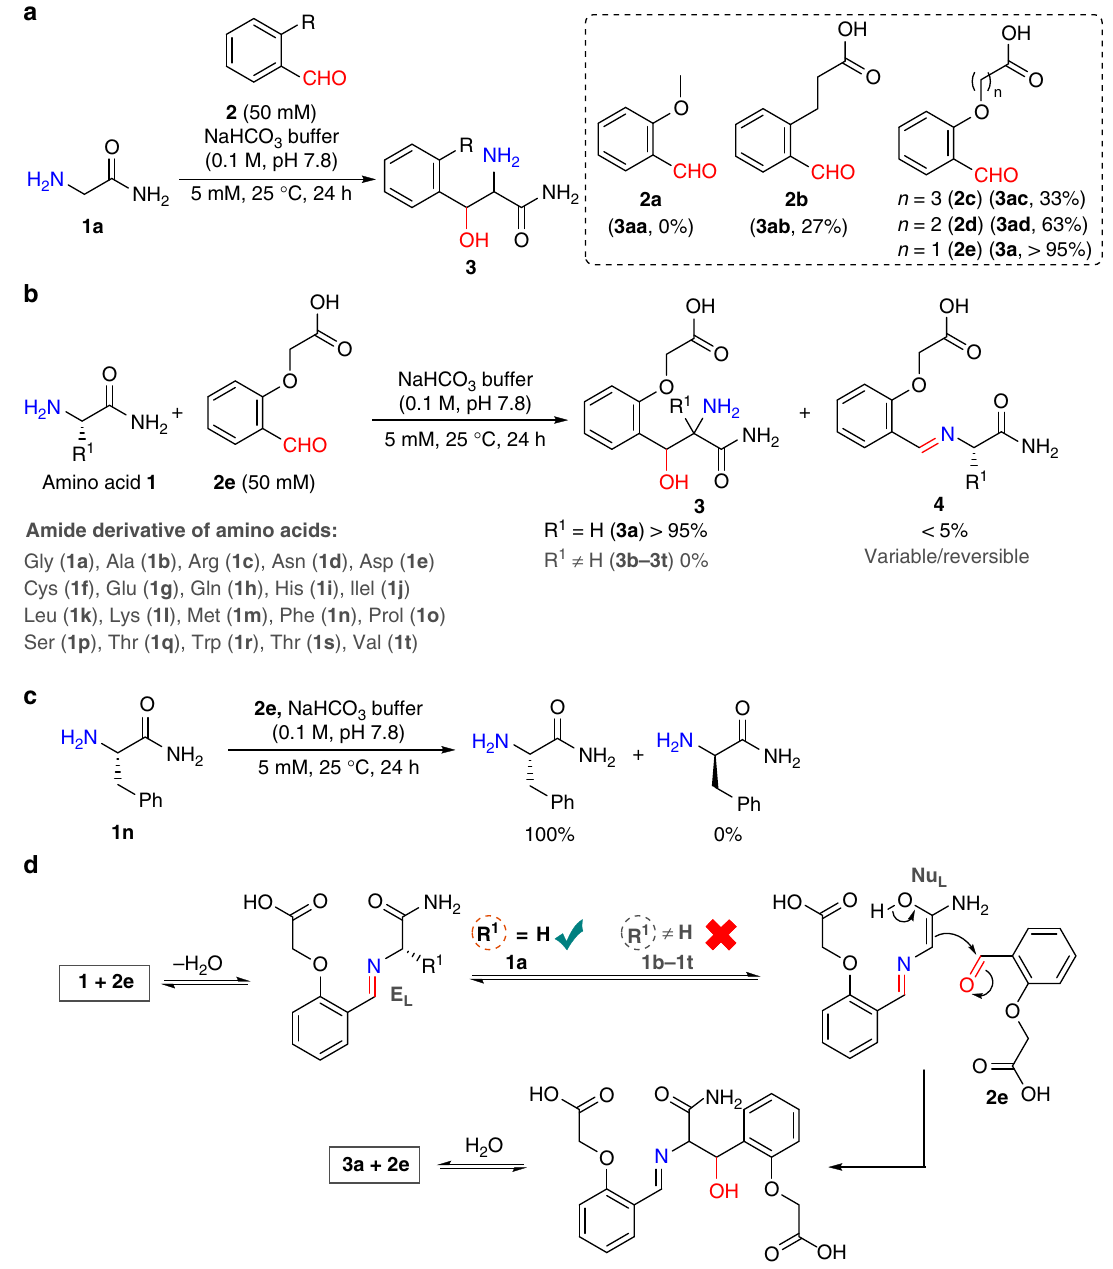
Fig. 2 Stable aminoalcohol formation with glycine. a Aldehyde with H-bond acceptors forms a stable aminoalcohol with 1a (also see Supplementary Fig. 72). b Selective formation of aminoalcohol with 1a . c Stereo-stability of substituted amino acid ( 1n ) under the reaction conditions. d Plausible mechanism for glycine speci fi c formation of